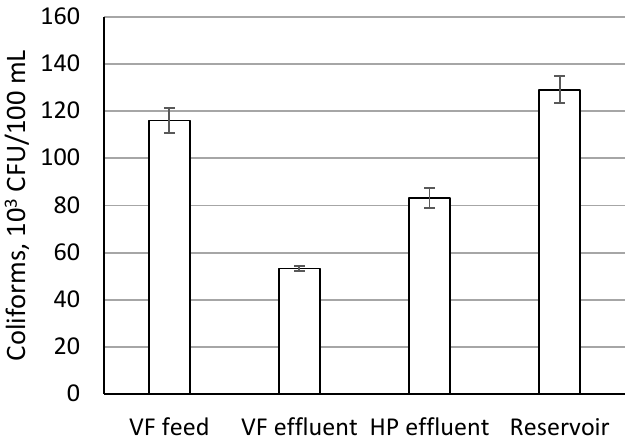
Figure 3. Total coliforms in wastewater at different process stages.